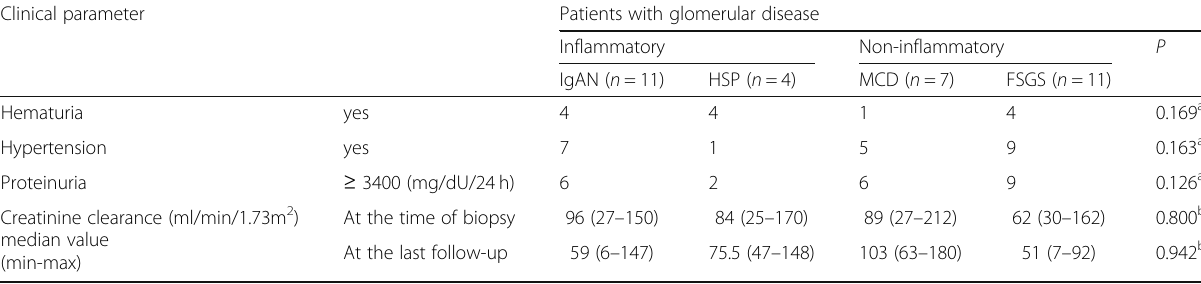
Table 1 Distribution of 33 patients according to the type of glomerular disease and clinical parameters Clinical parameter Patients with glomerular disease Inflammatory Non-inflammatory P IgAN ( n =